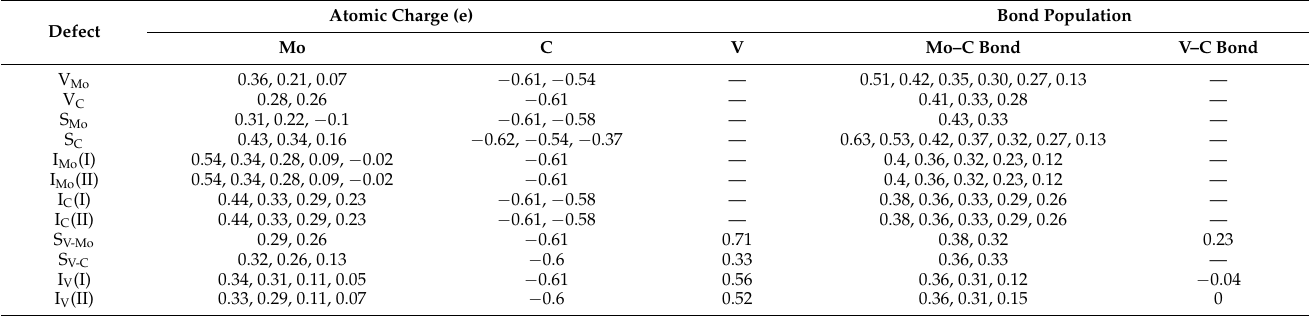
Figure 2. Structure model and electron density difference distribution (EDDD) after optimization in (1120) plane of Mo 2 C supercell with V-related defect of ( a , b ) V C and ( c , d ) S V-Mo . Cyan and grey balls represent Mo and C atom, red ball represent V atom; grey dashed circle shows the V C position. Table 2. Mulliken atomic charge and bond population in the supercell with different defects. In perfect Mo 2 C structure, atomic charge for Mo and C atom is 0.3 and − 0.6, respectively, and all Mo–C bond populations are 0.33. Note: the numbers in the table may vary by ±